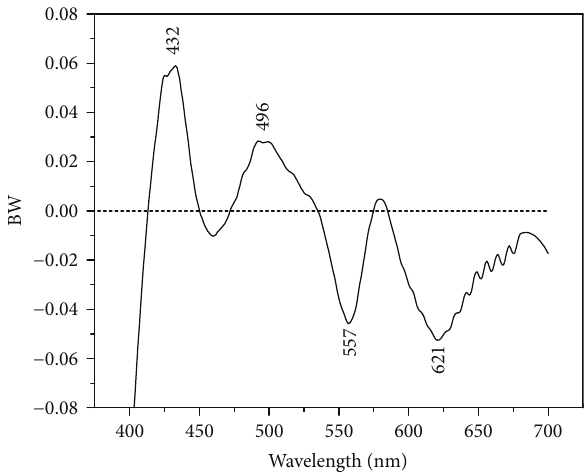
Figure 5: Principal component regression-weighted regression coe ffi cient (BW) for salmon meat spectra at di ff erent storage days.